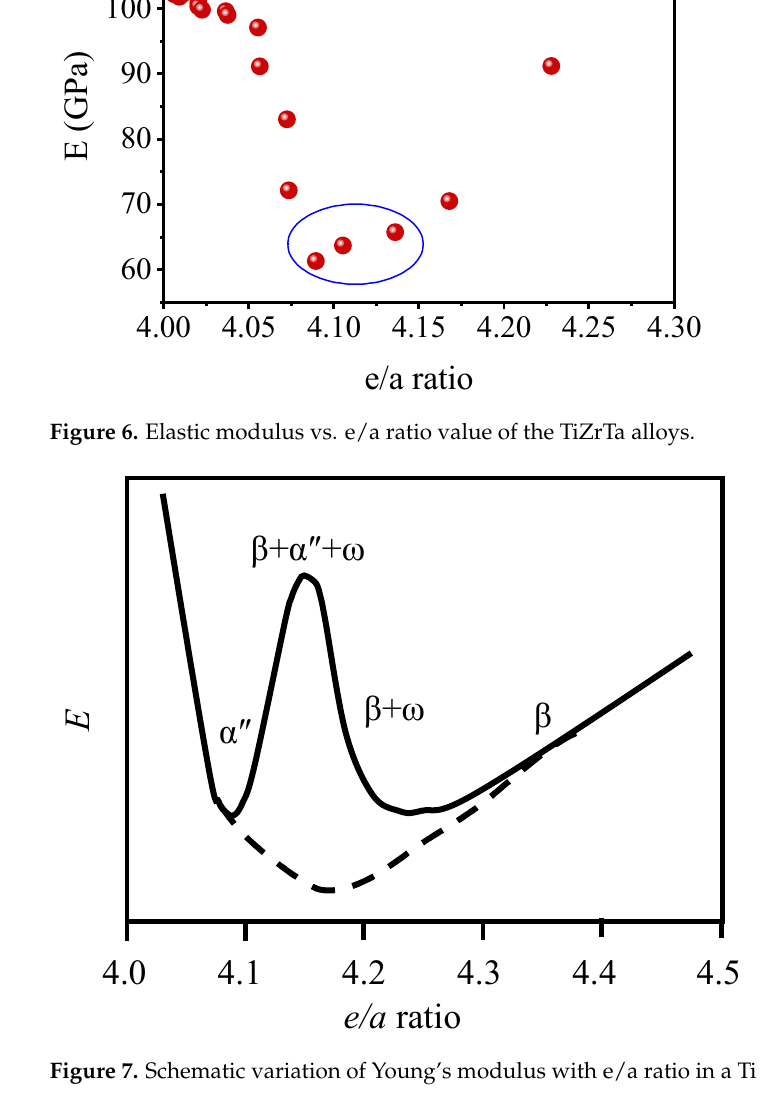
Figure 7. Schematic variation of Young’s modulus with e/a ratio in a Ti system [21].